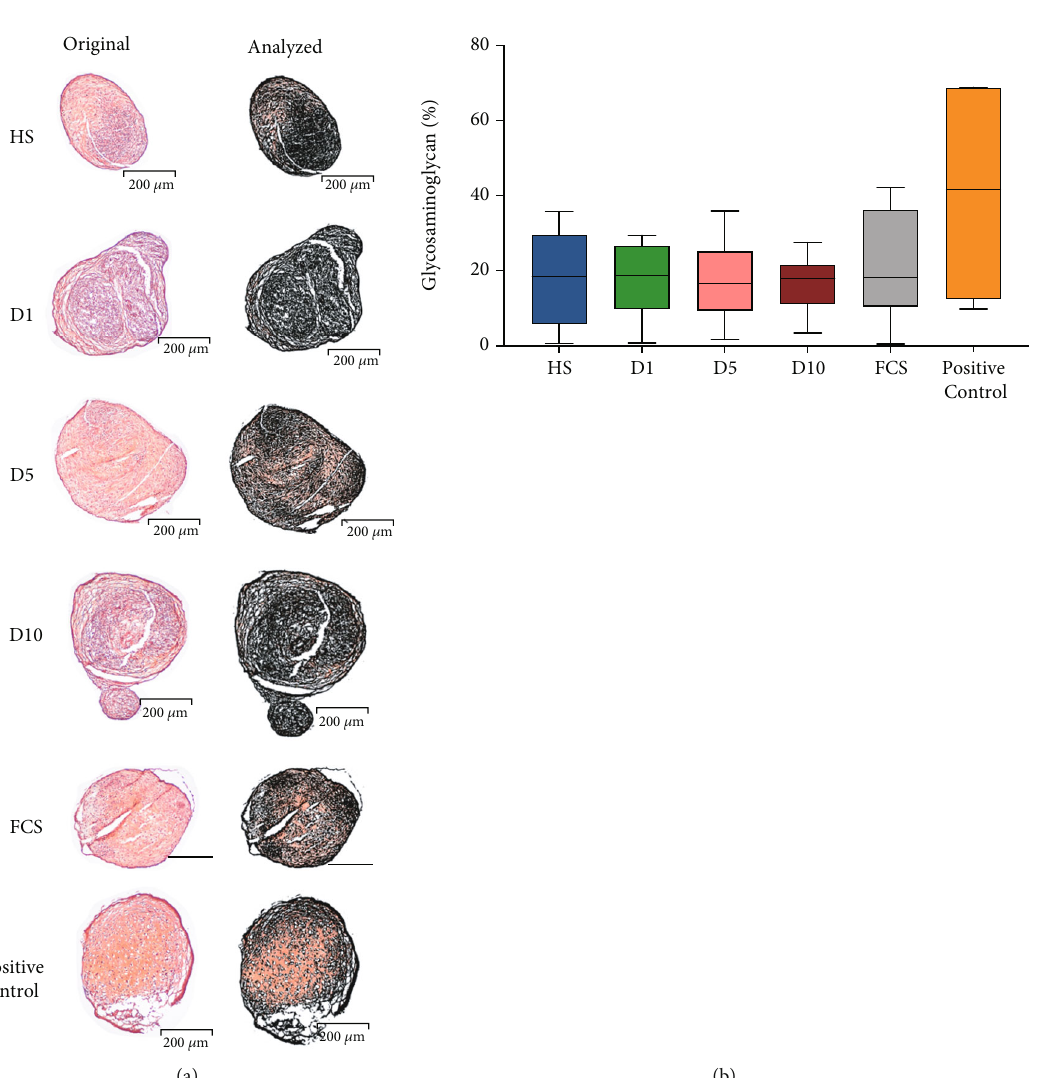
Figure 7: Chondrogenic di ff erentiation potential. (a) Chondrogenic di ff erentiation after 21 days of culture in chondrogenic induction medium containing either HS, D1, D5, D10 serum, FCS, or serum-free (positive control). Images were taken at a magni fi cation of 40x. Glycosaminoglycan content is depicted in orange. Demarcation of areas not stained positively for glycosaminoglycans in black using visual analysis software (based on OpenCV library version 4.1.0). Standard parameters were used in the analysis of each image. (b) Quantitative analysis of the glycosaminoglycan content of the chondrogenic pellet showed no signi fi cant di ff erences between di ff erent groups ( p > 0 : 05 , n = 4 , N = 2